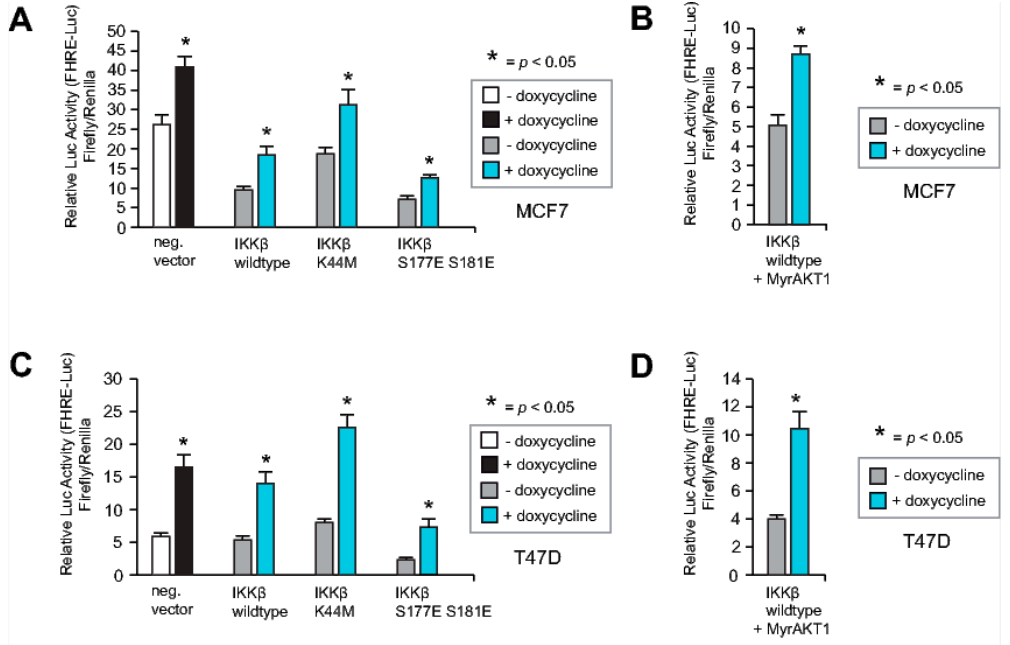
Figure 7. Neither IKK β nor AKT1 can override the RASSF1A-mediated increase in FOXO3A activity. ( A ) Conditional RASSF1A MCF7 [3] and ( C ) conditional RASSF1A T47D cells [3] were co-transfected